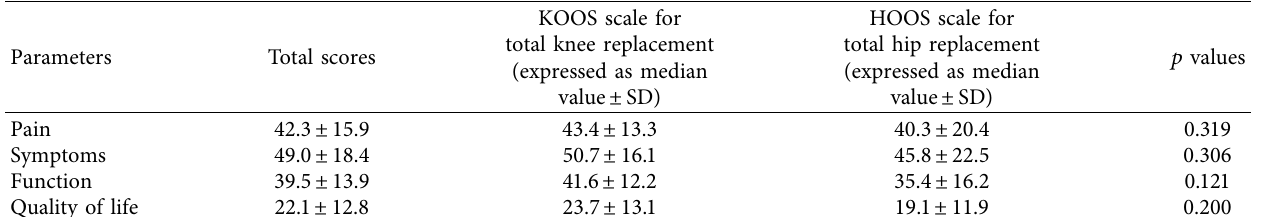
Table 6: Te KOOS and HOOS-quality of life assessment scales of the 56 patients who had THR or TKR.